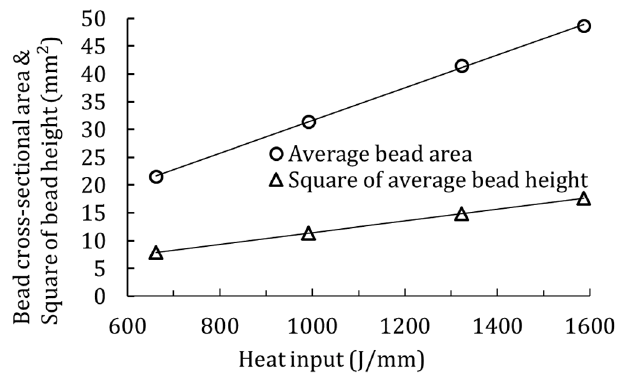
Figure 5. Bead cross-sectional area and square of height according to heat input.